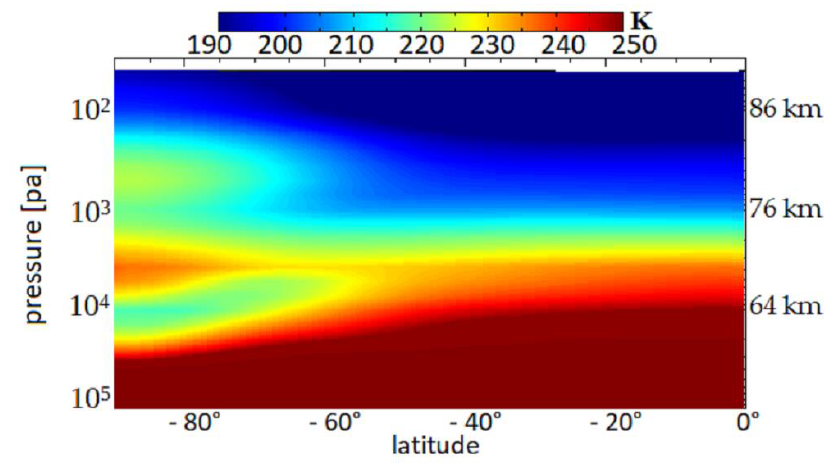
Figure 1. Altitude–latitude distribution of the zonal and temporal average temperature field (K) for the Institut Pierre Simon Laplace (IPSL) Venus general circulation model (GCM) simulation. The average has been obtained over 360° of longitude and the entire night.